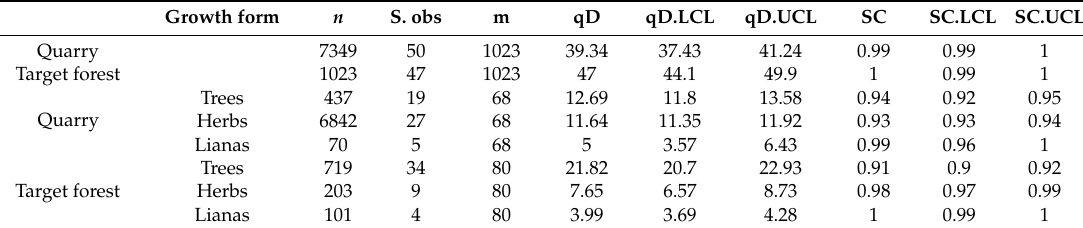
Table 3. The growth form diversity estimates of the studied quarries and target vegetation. Growth